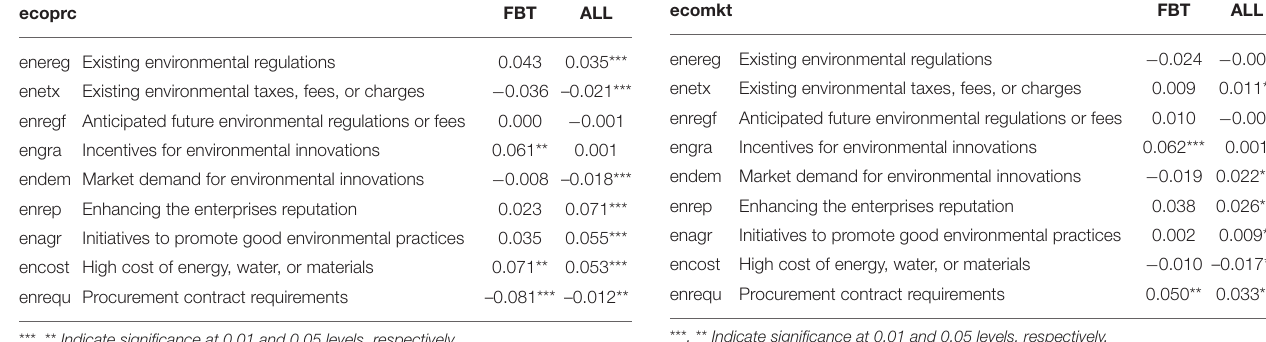
TABLE 7 | Multivariate regression parameters to determine the factors that contribute to the circular benefits of market innovations. ecomkt FBT ALL